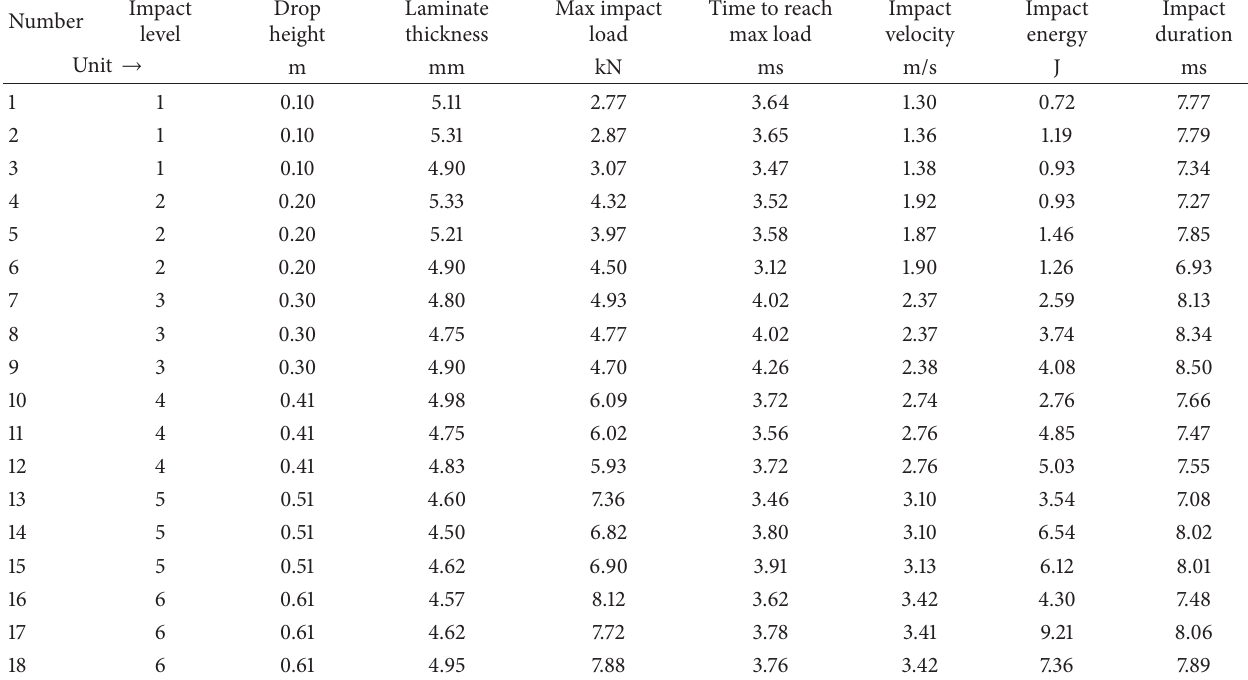
Table 3: E-Glass Epoxy experimental results.